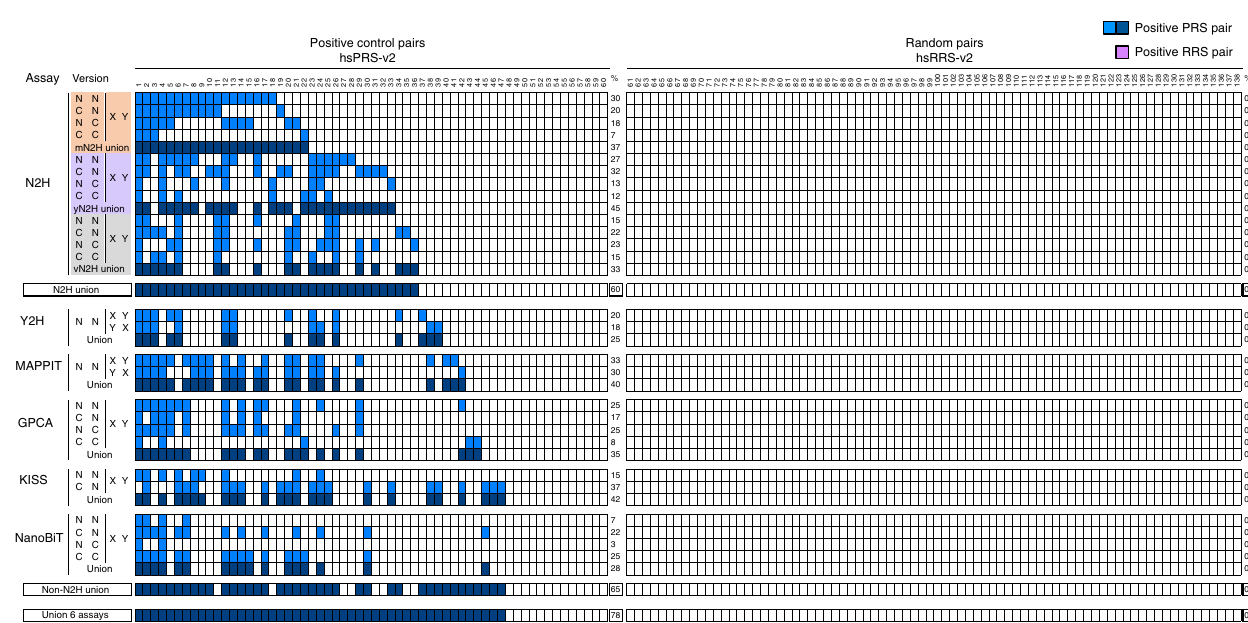
Fig. 6 Complementarity of different assay versions. Detection of individual hsPRS-v2 pairs (left panel) by the assay versions used in Fig. 5a – c, under conditions where none of the hsRRS-v2 pairs (right panel) are scored positive. Detected hsPRS-v2 pairs are indicated by blue squares: light blue corresponds to individual assay versions and dark blue to the union of assay versions into distinct assays or combinations of assays. Identity of pairs can be found in Supplementary Table